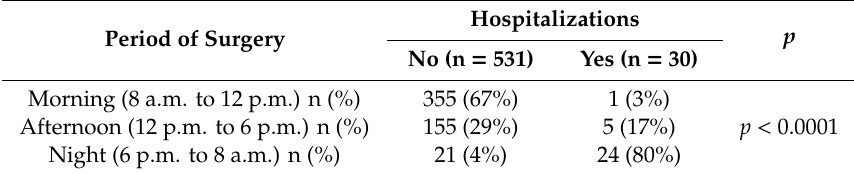
Table 3. Hospitalizations according to the time of day when surgery was